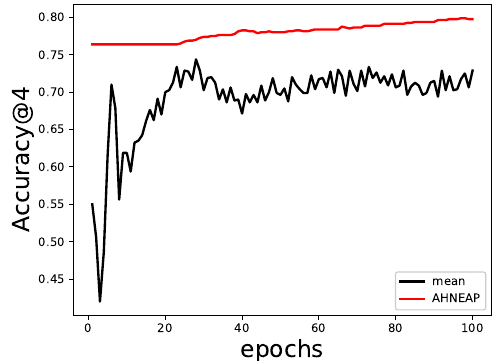
Figure 5. Prediction accuracy of B02 in all